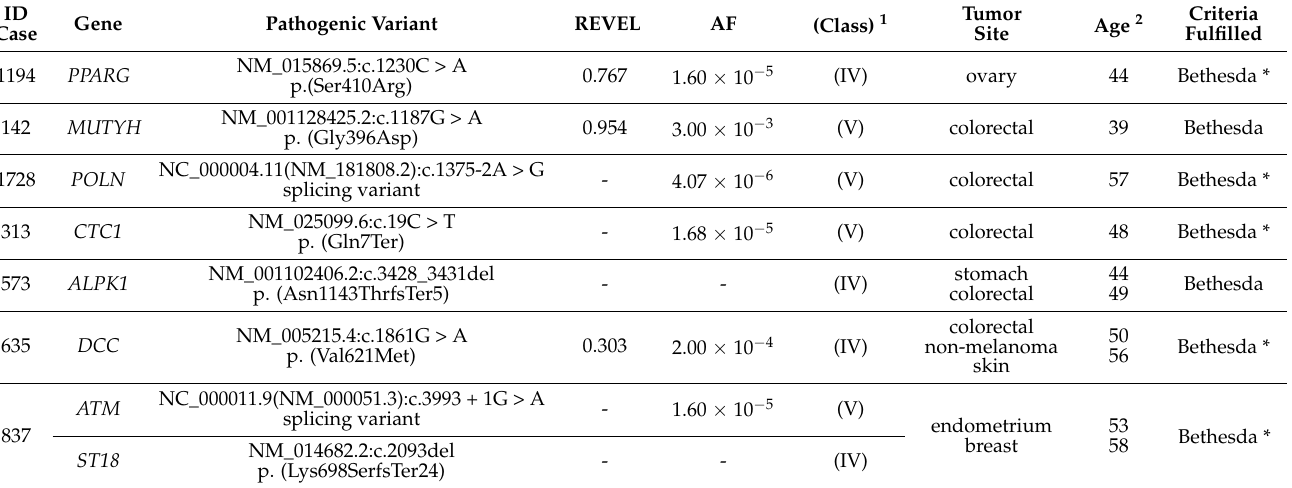
Figure 3. Representative plot of patients carrying pathogenic and likely pathogenic variants (genes on the top) and VUS (only for genes with over 5% VUS in our patients with Lynch-like syndrome). Table 2. Pathogenic (V) or likely pathogenic (IV) variants identified in our patients with Lynch-like syndrome.